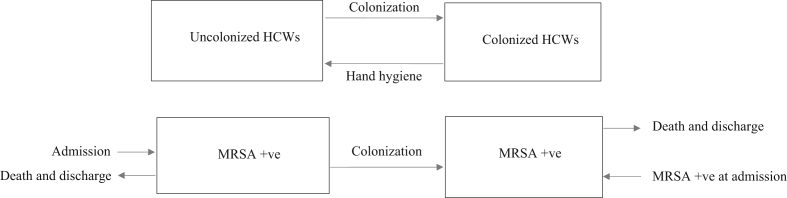
Model structure.